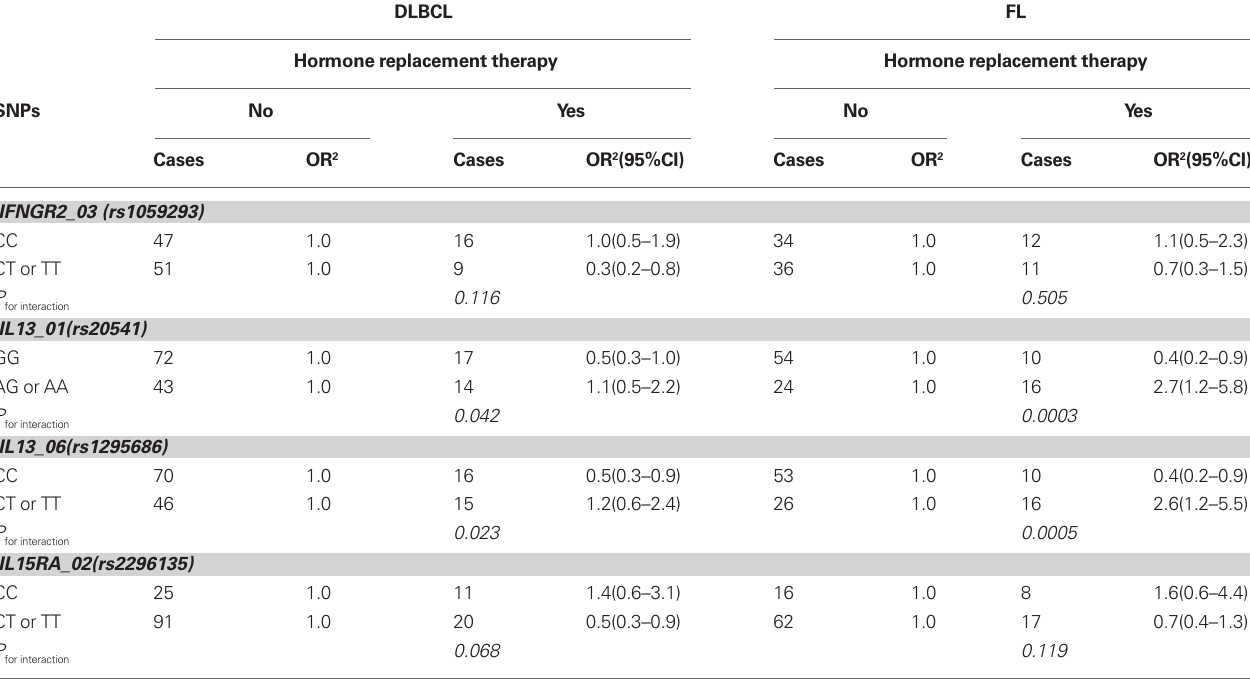
Table 3 | Associations between Th1/Th2 cytokine polymorphisms, hormone replacement therapy, and risk of common B-cell lymphoma subtypes 1 . DlBCl